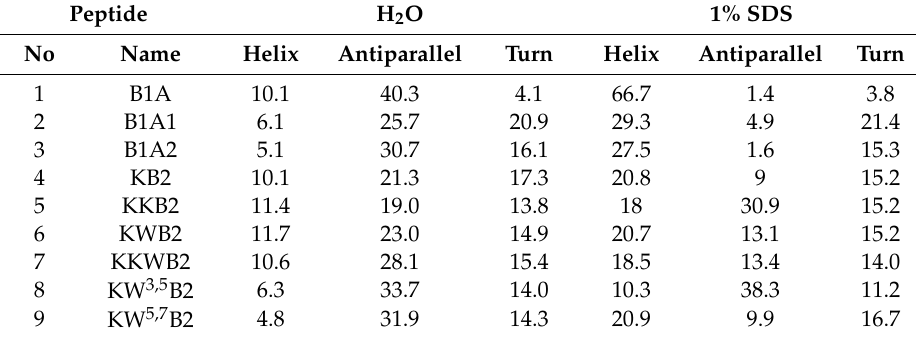
Figure 2. ( a ) Helical wheel representation of all peptides. ( b ) Predicted 3D models of all peptides circular dichroism (CD) spectra of B1A and its analogues. The peptides were tested in aqueous solution ( c ) and 1% SDS micelles solution ( d ), respectively. Table 2. Secondary structure analysis of B1A and its analogues.